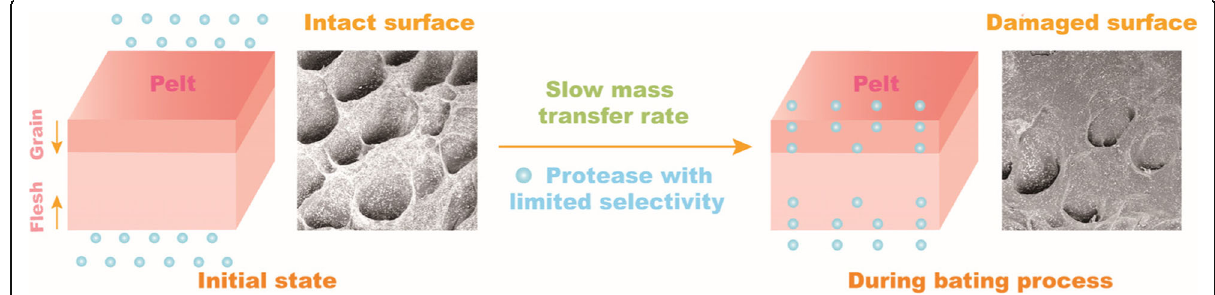
Fig. 1 Schematic diagram of protease transfer rate in pelt during bating. Higher concentration and longer retention time of protease in the surface layer than in the middle layer are prone to cause a dramatic damage to the natural pattern of the pelt